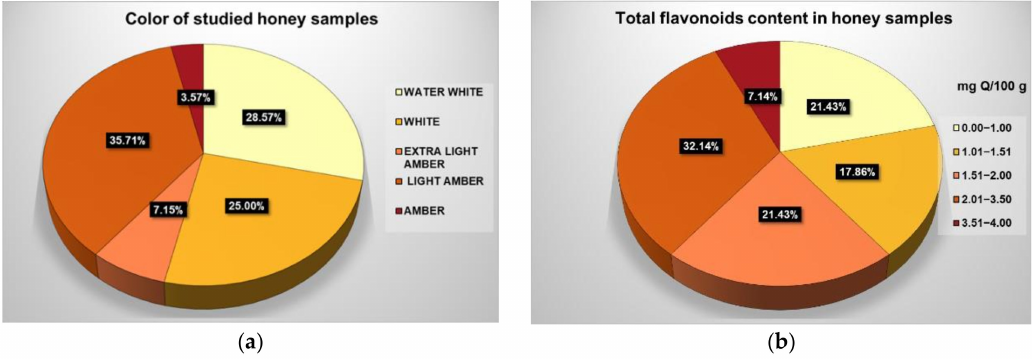
Figure 6. Visual presentation of correlation between ( a ) color and ( b ) total flavonoid content of honey